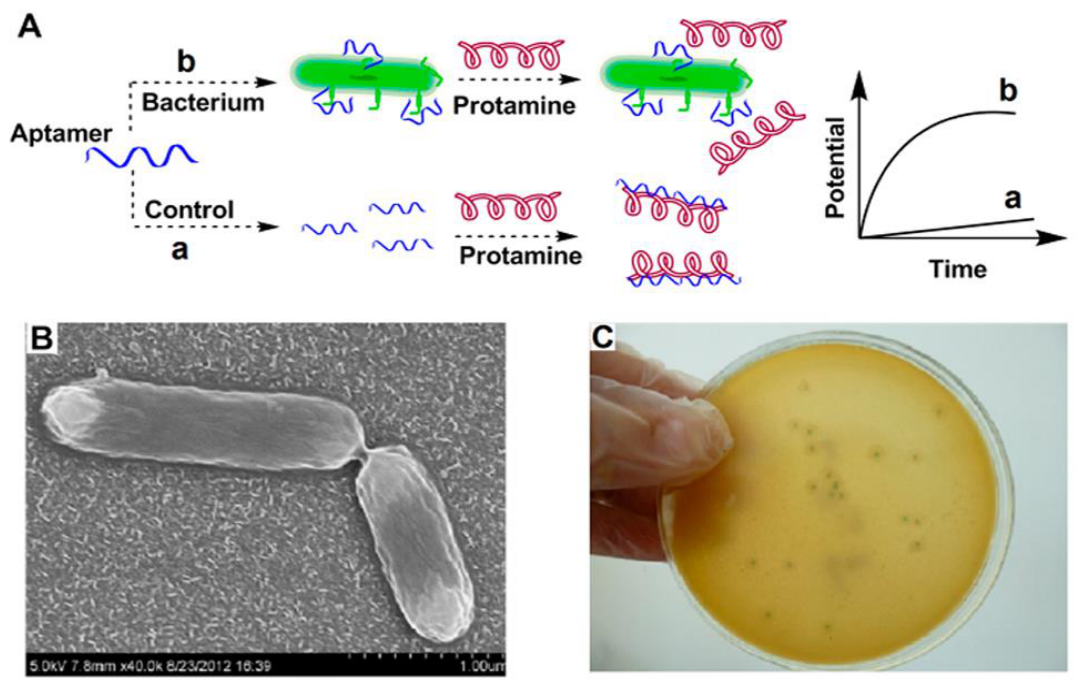
Figure 3. An example of an aptasensor binding with a Listeria surface protein (Internalin A). Protamine is a positive-charge substance that reacts with aptamer alone and with a bacteria – aptamer complex. Each of these reactions causes specific potential changes. The polymeric polycation-sensitive membrane can detect the presence of this composition. ( A ) Mechanism of biosensor, ( B ) Scanning electron microscope (SEM) illustration of bacteria and ( C ) Image of the cultured bacteria. Copyright (2022) from ACS publications [11].